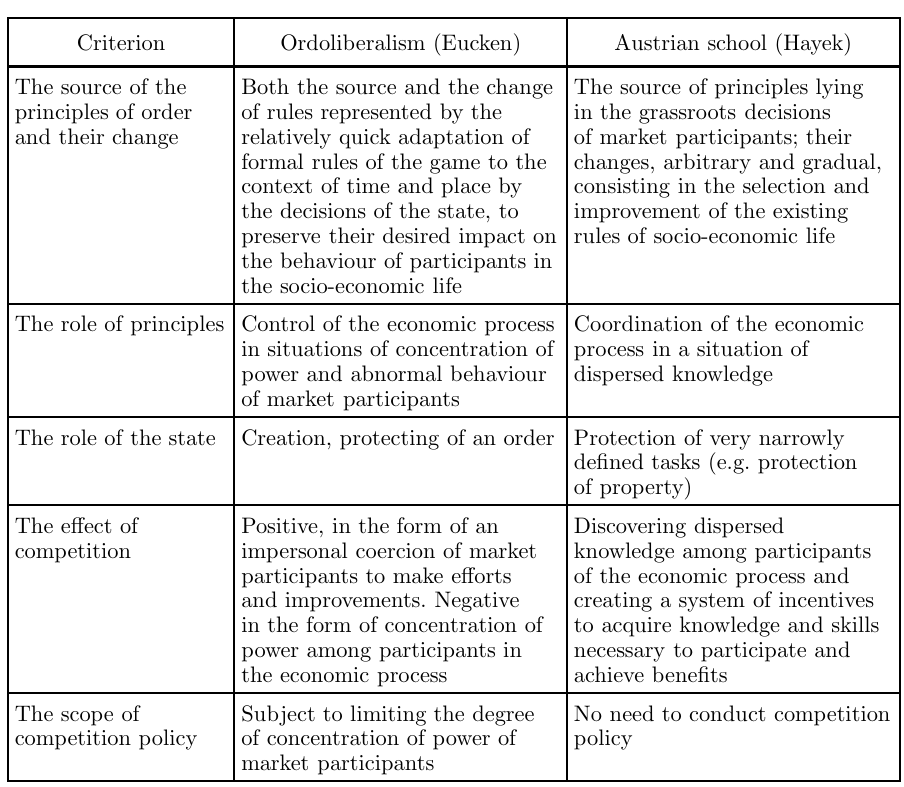
The source of principles lying in the grassroots decisions consisting in the selection and improvement of the existing rules of socio-economic